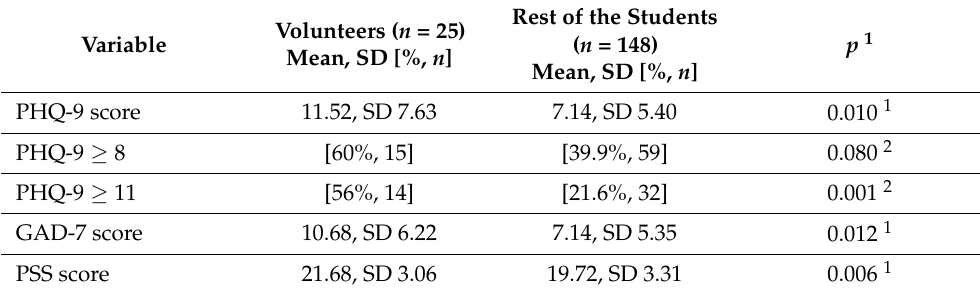
Table 2. Differences in psychological wellbeing between volunteer participants and non-volunteer